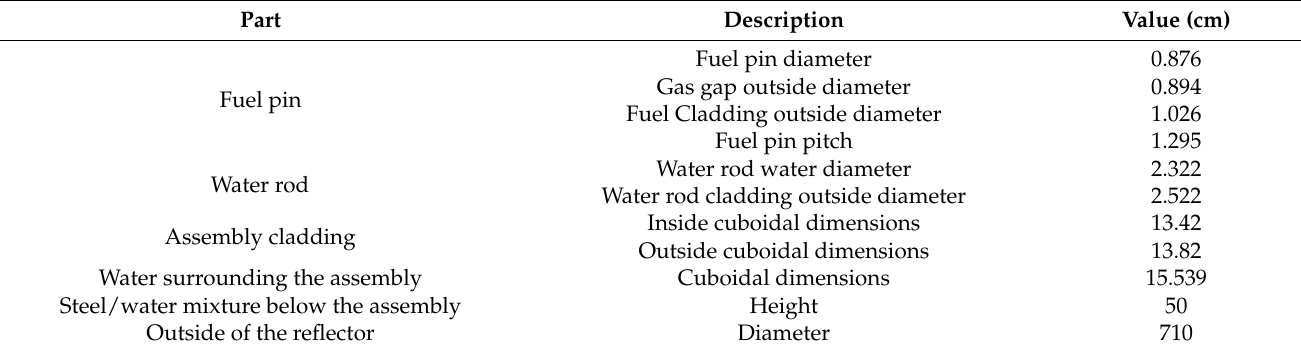
Table A3 provides an overview of the materials that are within the core. Table A3. Material information